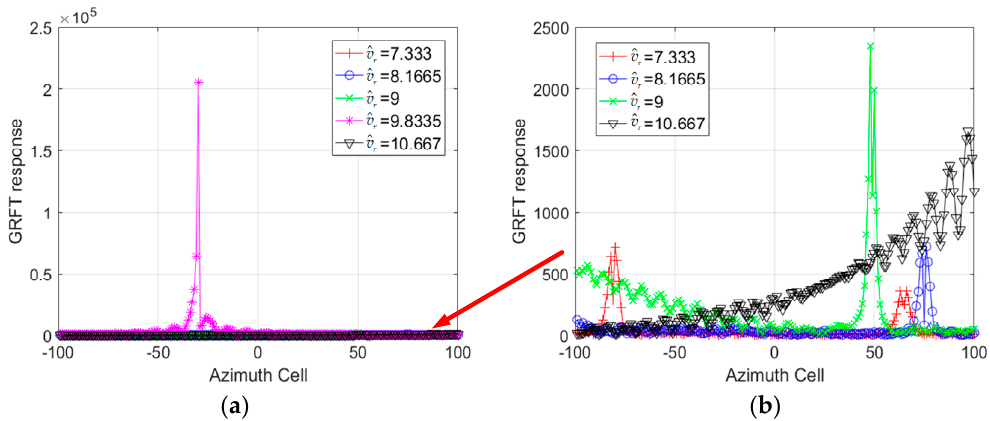
Figure 4. Azimuth profile of GRFT responses to radial velocity’s coarse searching: ( a ) all coarse-searched radial velocities (the pink line represents | ˆ v r − v r | ≤ ρ r / T ); ( b ) enlarged view of GRFT response when | ˆ v r − v r | > ρ r / T .